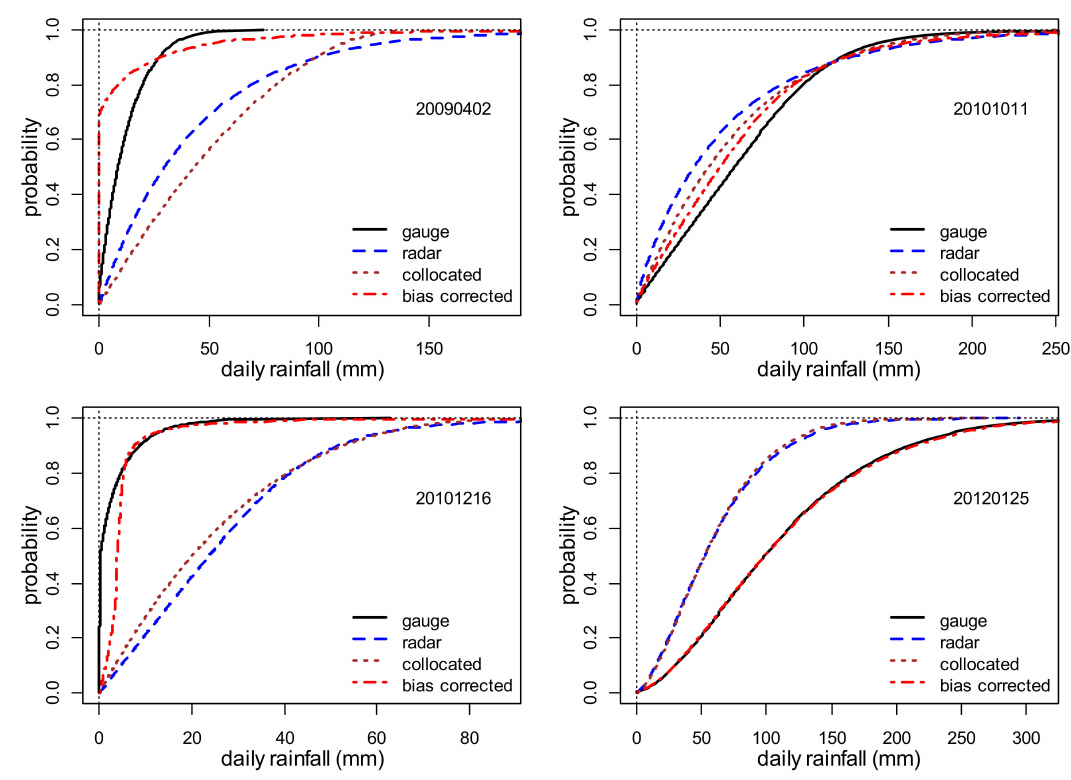
Figure 4. Bias correction applied to the rain gauge probabilities and the radar rainfall amounts to obtain the “true” bias corrected marginal